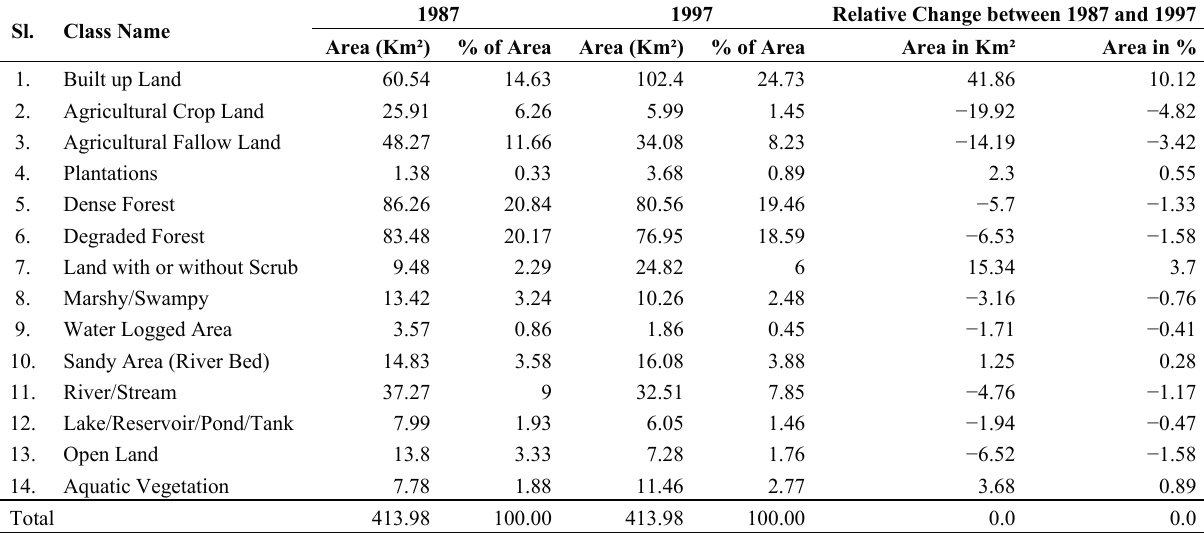
Table 5. Area statistics and relative changes of each land use and land cover changes category between 1987 and 1997.